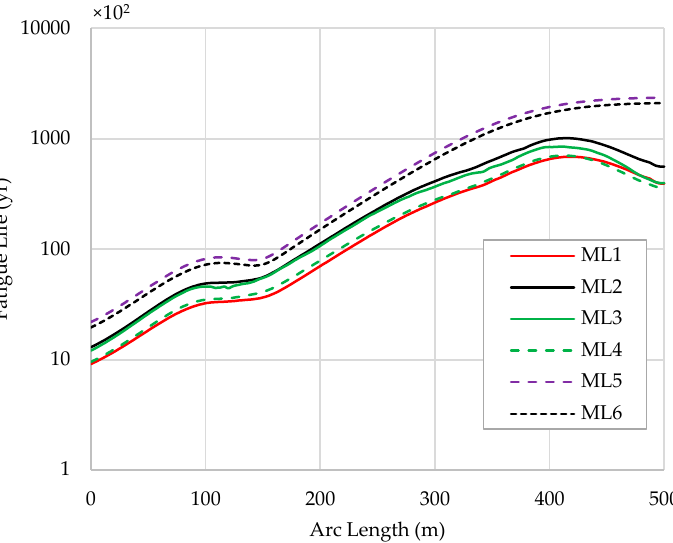
Figure 19. Mooring fatigue life along the arc length for ML1 to ML6. Arc length 0 m and 500 m indicate the fairlead and anchor point locations, respectively.